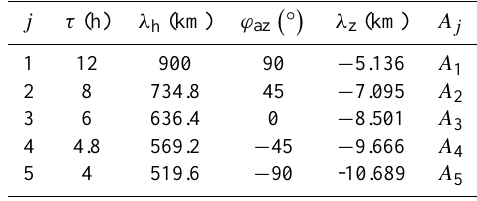
Table 2a. Properties of five upward propagating AGWs with 180 ◦ azimuth spreading to be superposed.